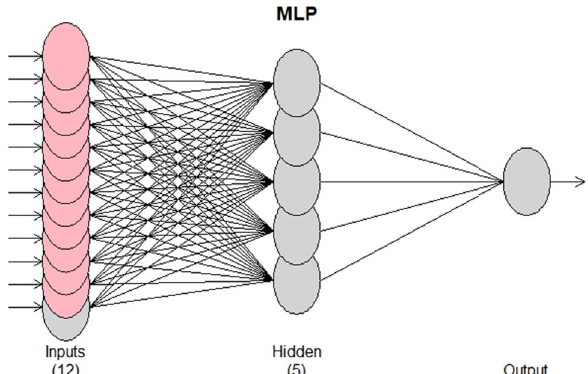
Figure 6. MLP model.